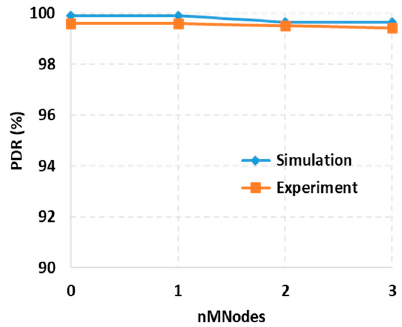
Figure 14. Comparison of packet delivery ratio for experiment and simulation ( K = 6 in simulations).